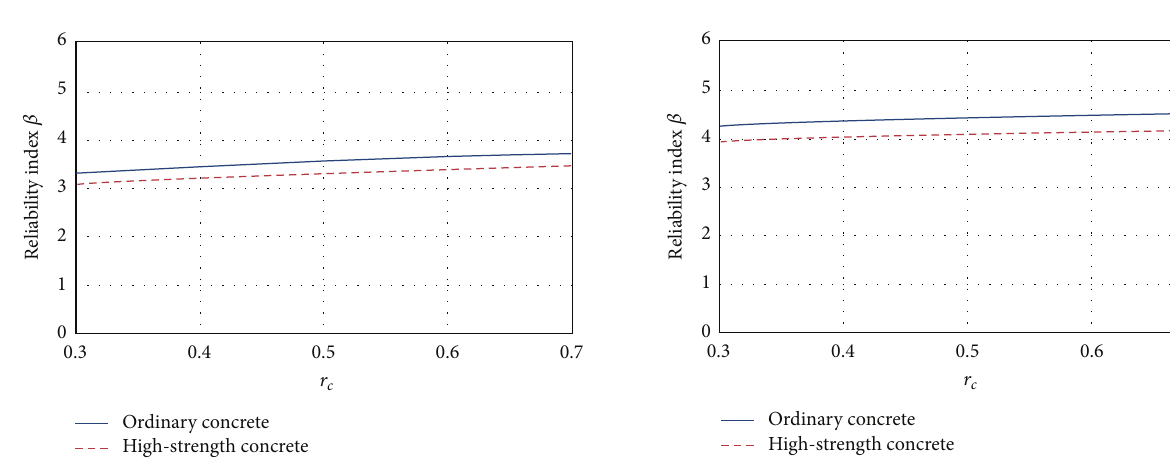
Figure 3: Reliability corresponding to flexure failure mode.